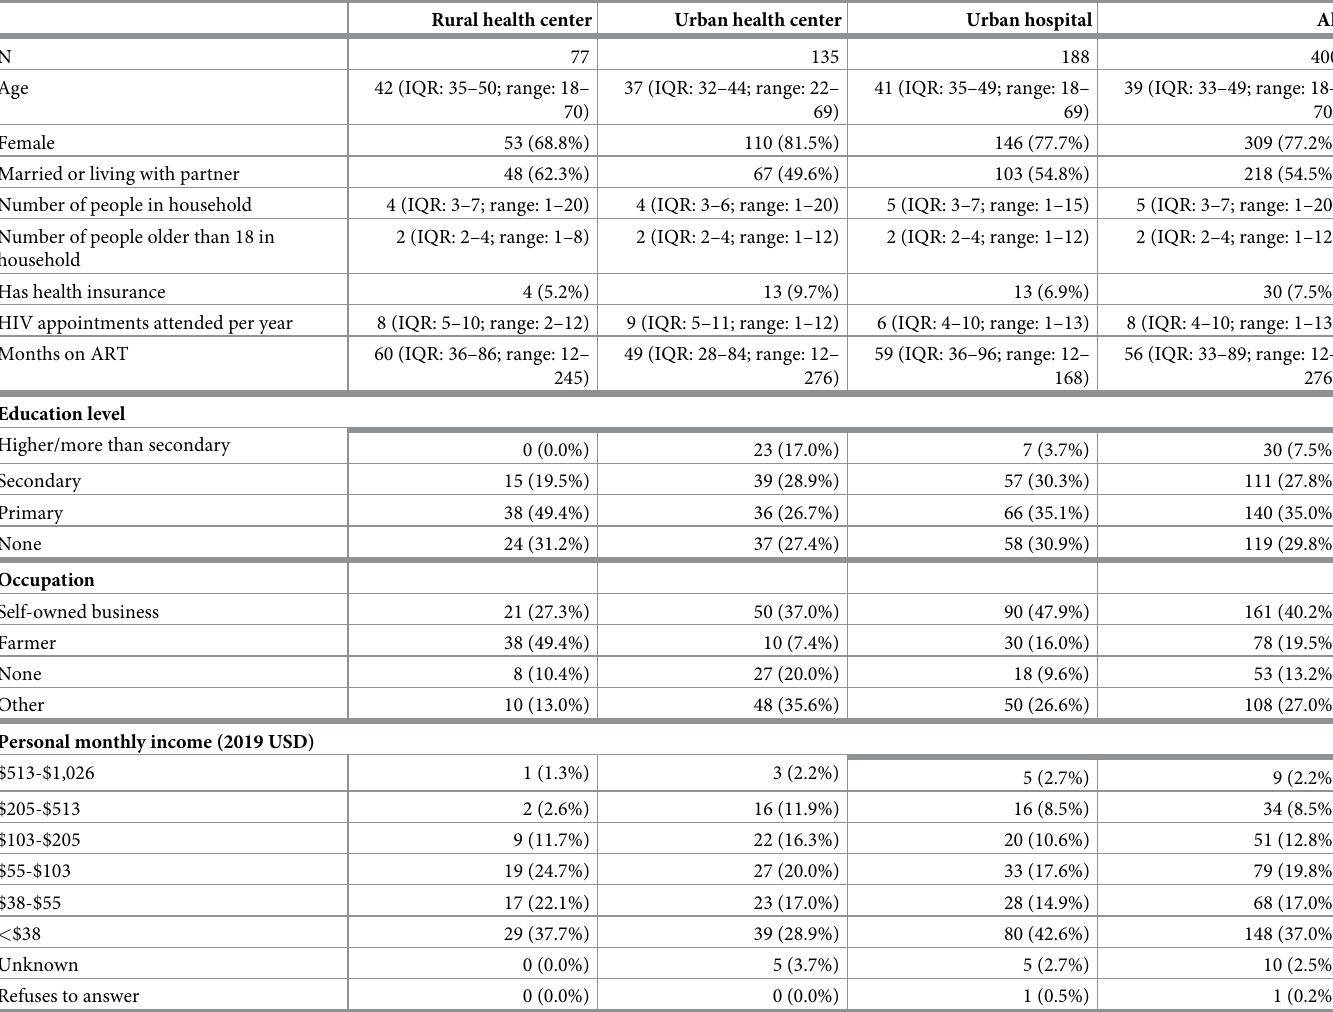
Table 2. Overview of participants by facility type and